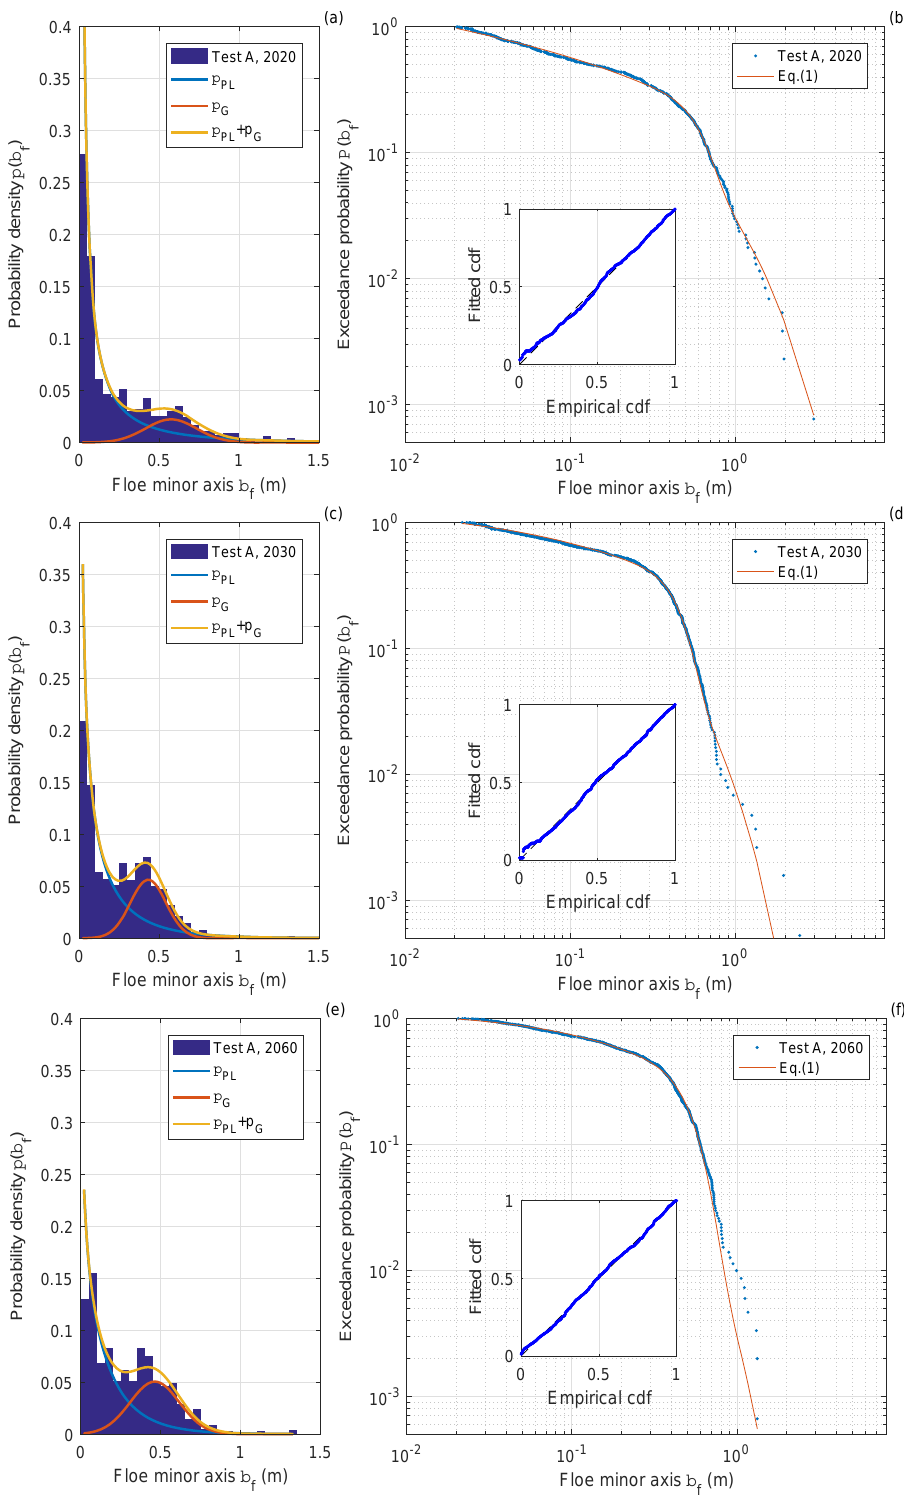
Figure 7. Results of the linear least-squares fit of predicted and observed CDFs for b f data from test group A: histograms of b f with fitted p PL , p G , and p l (a, c, e) and observed exceedance probabilities with fitted P l (b, d, f) . The insets show P – P plots of the fitted vs. observed